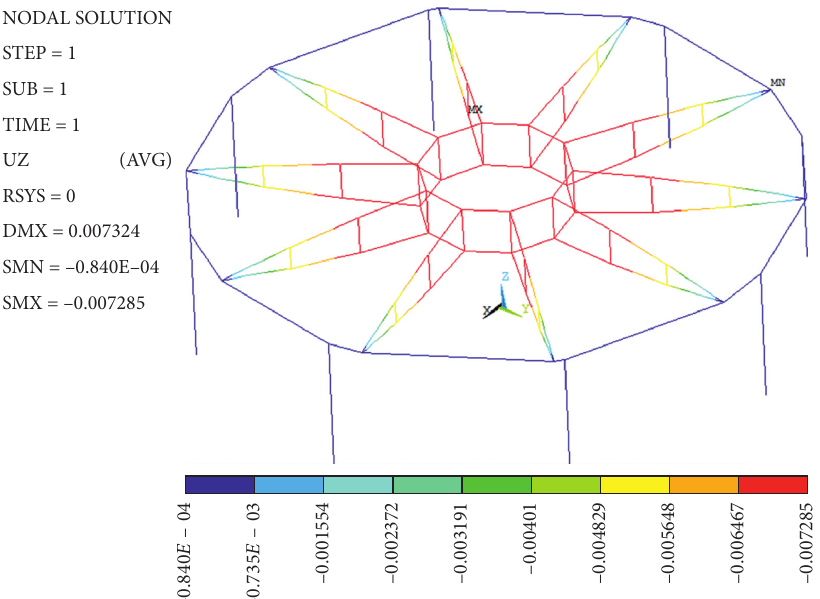
Figure 9: Finite element model of spoke-type cable truss.